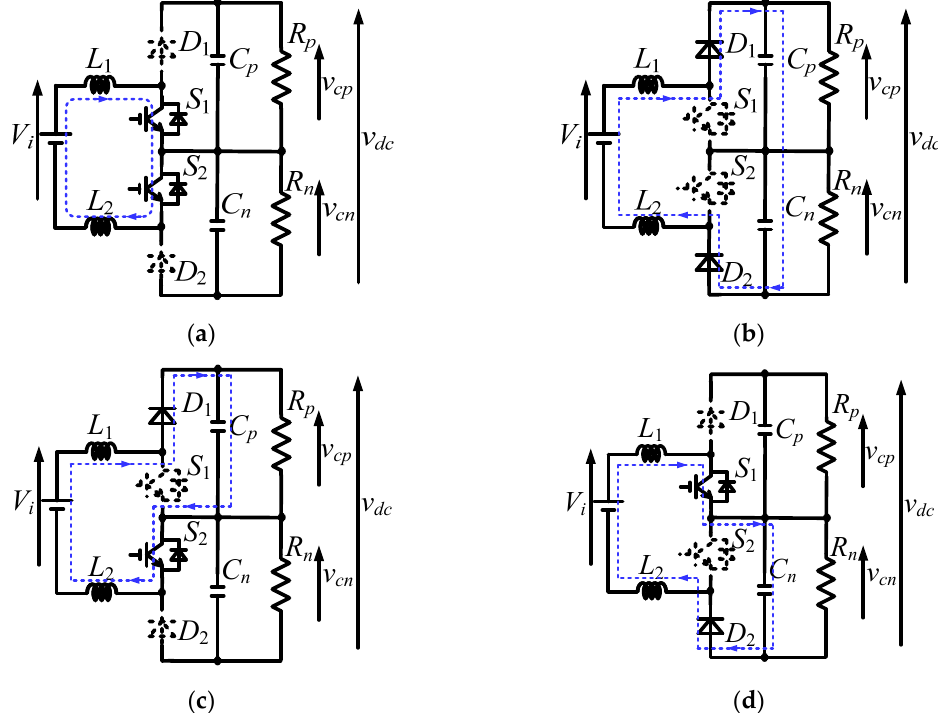
Figure 5. Switching modes of series circuit. ( a ) MODE1; ( b ) MODE2; ( c ) MODE3; ( d ) MODE4.